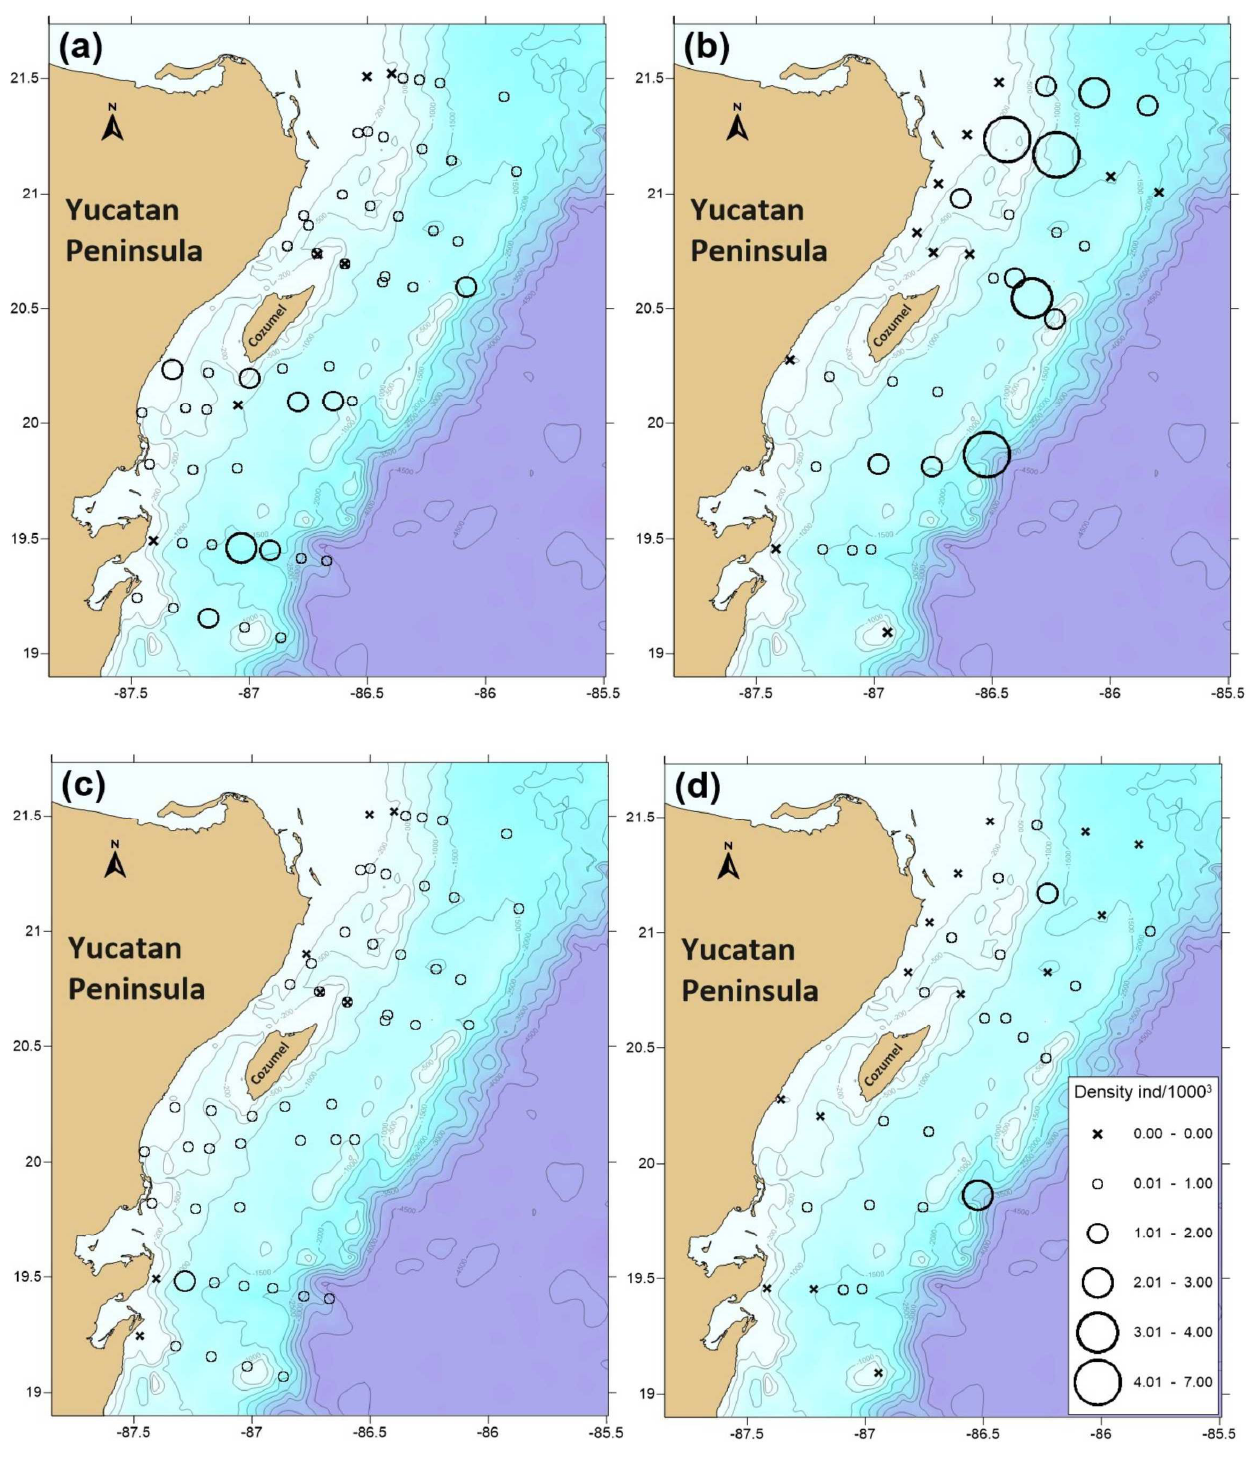
Figure 5. Density (number of larvae per 1000 m 3 of water) of phyllosomata of Panulirus argus by sampling station. ( a ) mid- stage phyllosomata, autumn cruise; ( b ) mid-stage phyllosomata, spring cruise; ( c ) late-stage phyllosomata, autumn cruise; ( d ) late-stage phyllosomata, spring cruise. The scale is the same for all